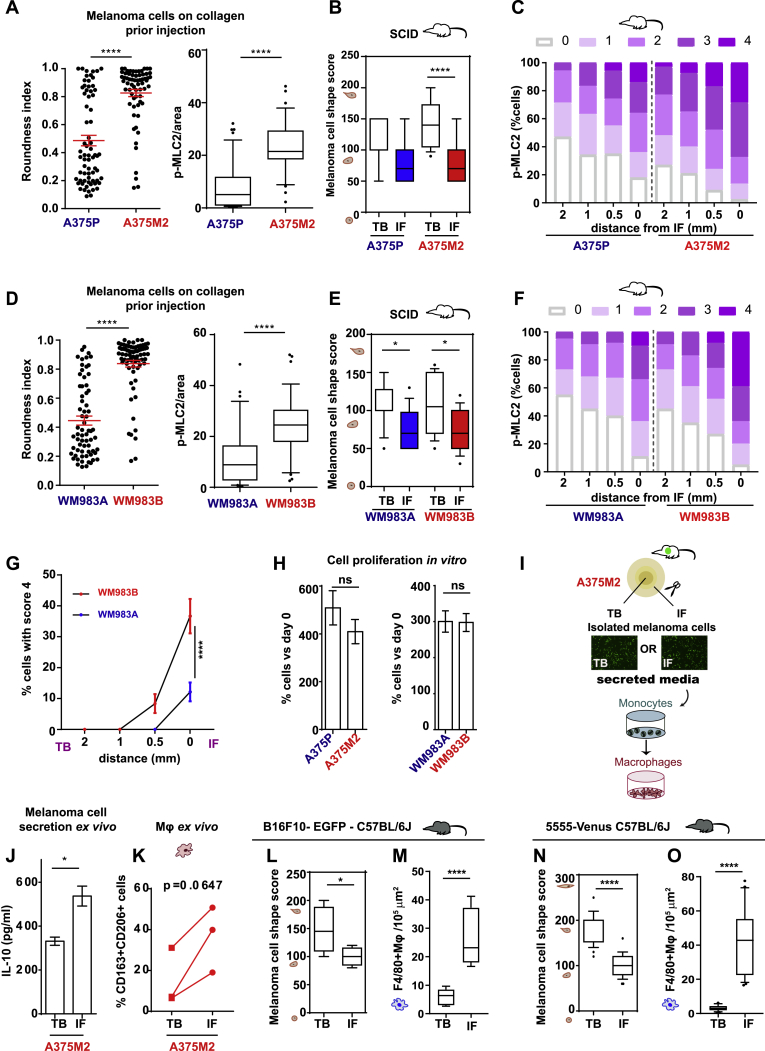
AATME Composition Is a Conserved Feature in Melanoma In Vivo, Related to Figure 4(A) (Left) Roundness index and (right) p-MLC2 levels/area, in EGFP-A375P and EGFP-A375M2 cells seeded on top of collagen I. Quantification corresponds to the area occupied by p-MLC2 staining normalized by the total area of the cell.(B) Melanoma cell shape score in TB and IF of A375P and A375M2 tumors (n = 8 mice/group).(C) Percentage of melanoma cells with score 0-4 for p-MLC2 at different distance from IF (0-2 mm) for A375P and A375M2 tumors, as tested by IHC (n = 8 mice/group).(D) (Left) Roundness index and (right) p-MLC2 levels/area, in EGFP-WM983A and EGFP-WM983B cells seeded on top of collagen I.(E) Melanoma cell shape score in TB and IF of WM983A and WM983B tumors (n = 8 mice/group).(F) Percentage of melanoma cells with score 0-4 for p-MLC2 at different distance from IF (0-2 mm) for WM983A and WM983B tumors (n = 8 mice/group).(G) Percentage of melanoma cells with score 4 for p-MLC2 at different distance from IF (0-2 mm) for WM983A and WM983B tumors, as tested by IHC (n = 8 mice/group).(H) Cell proliferation rates of (left) A375P versus A375M2 and (right) WM983A versus WM983B cells. Data are presented as fold change versus day 0.(I) Schematic shows the isolation of melanoma cells from TB or IF of A375M2 tumors.(J) Concentration of secreted IL-10, as measured by ELISA, in melanoma cells isolated from TB or IF of A375M2 tumors (n = 3).(K) Percentage of CD163+CD206+ macrophages after treatment with CM from melanoma cells isolated from TB or IF of A375M2 tumors (n = 2; 2 different healthy donors; 2 matched TB/IF samples; 1 pair used twice with 2 different donors).(L and M) (L) Melanoma cell shape and (M) F4/80+ macrophages, in TB and IF of B16F10 tumors (n = 8 mice).(N) Melanoma cell shape score and (O) F4/80+ macrophages, in TB and IF of tumors generated 8 days post-intradermal injection of Venus- 5555 cells (n = 5 tumors).(A left, D left, G, and H) Graphs and dot blots show mean ± SEM. (A right, B, D right, E, and L–O) Boxplots show 10-90 percentile. (A, D, H, J, L–O) t test. (K) paired t- test. (B and E) One-way ANOVA with Tukey post hoc test. (G) Two-way ANOVA with Bonferroni post hoc test.ns p > 0.05,∗p < 0.05,∗∗p < 0.01,∗∗∗p < 0.001,∗∗∗∗p < 0.0001